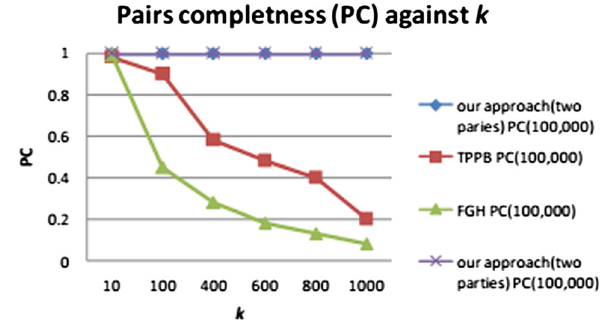
Fig. 9 Blocking Time with different values for k , dataset size = 100,000